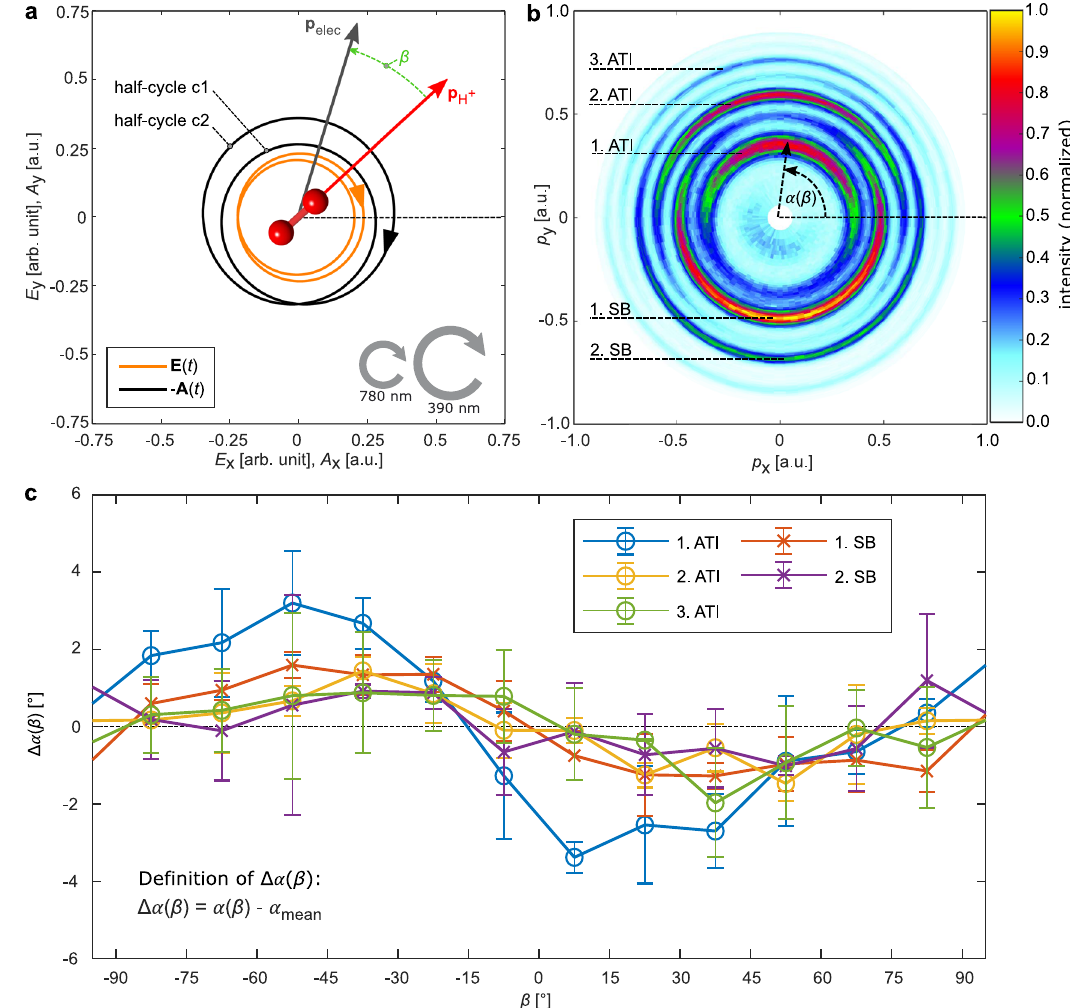
Fig. 2 Overview of the experimental quantities that give access to changes of the Wigner time delay. a Electric fi eld E ( t ) and negative vector potential − A ( t ) for one cycle of the co-rotating two-color (CoRTC) fi eld comprised of a high-intensity pulse (central wavelength of 390 nm) and a low-intensity pulse (central wavelength of 780 nm). The helicities of the two pulses are indicated with arrows. Using that the ion ’ s momentum vector p H þ always points along the molecular axis allows for the measurement of the orientation of the molecular axis. p H þ is measured in coincidence with the electron momentum vector p elec . As illustrated, β is the electron emission angle relative to the molecular axis in the polarization plane. b Measured electron momentum distribution in the polarization plane of the laser ’ s electric fi eld: ATI and SB peaks are half-rings which are spaced by the energy of a photon of the weaker laser pulse at 780 nm (1.6 eV). The most probable electron emission direction, α ( β ), is indicated for the fi rst ATI peak. c Changes in the most probable electron angle, Δ α , as a function of β are presented for each ATI/SB peak separately. α mean is determined for every energy peak independently as the mean of α ( β ) over all β (see Fig. S1). The values for the vector potential and the electron momentum are in atomic units (a.u.). The error bars show the standard deviation of the statistical